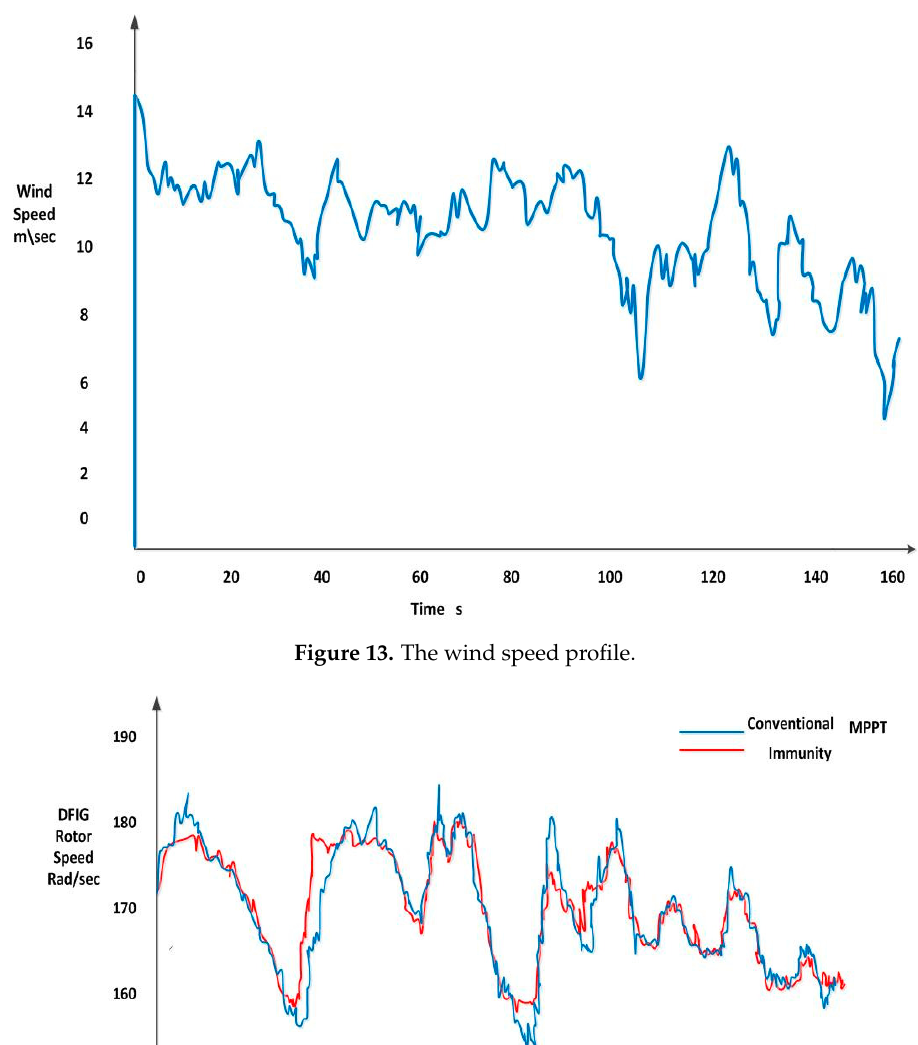
Figure 12. Non-linear control tracking rotor quadrature and direct currents and their references.